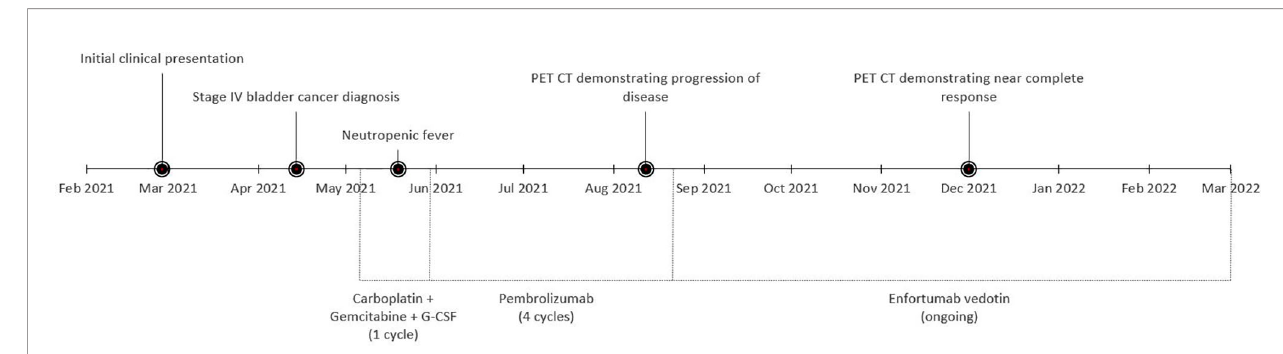
FIGURE 3 | Timeline of events across the treatment course of the